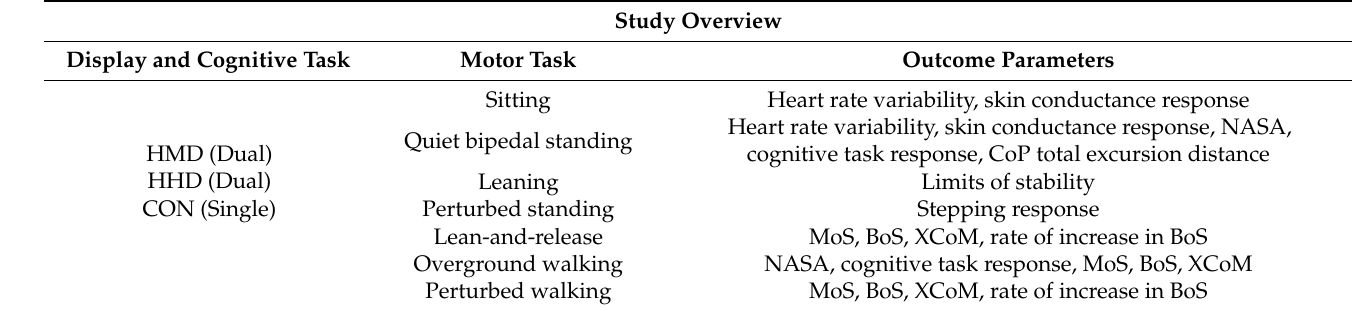
Table 1. Study overview including type of motor task, type of display and cognitive task and the per- formance criteria. Each motor task was performed using three display conditions in counterbalanced order: head-mounted display (HMD), hand-held display (HHD) and no display